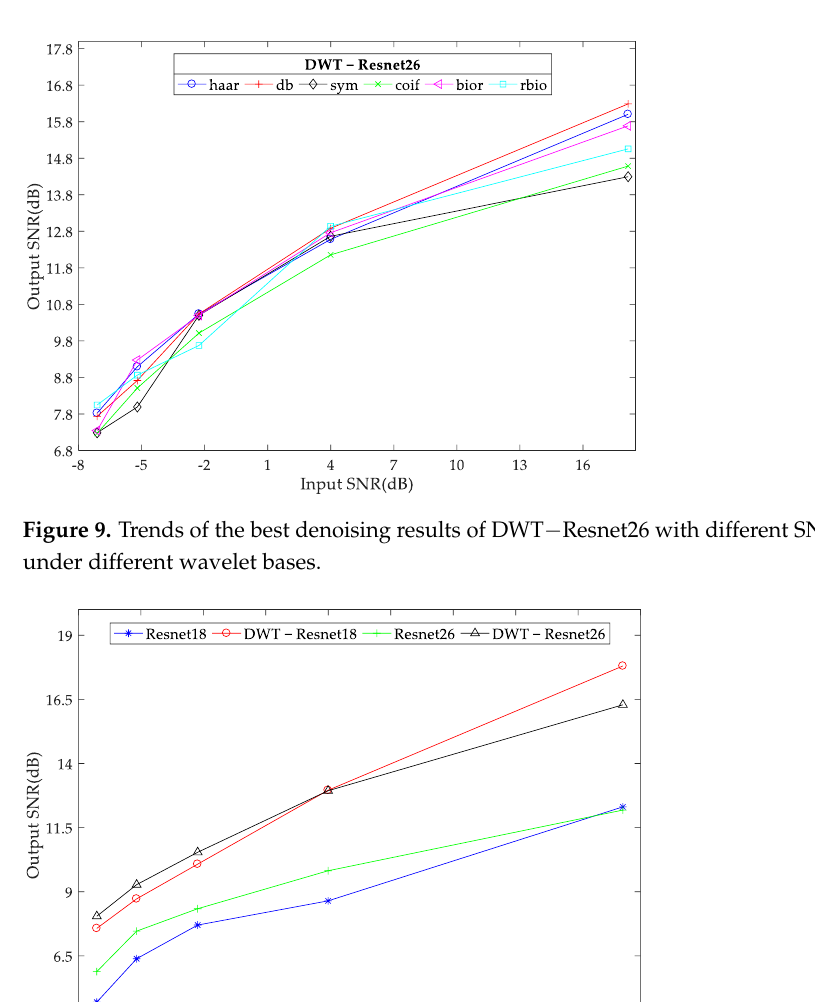
Figure 10. Comparison of denoising results using Resnet18, Resnet26, DWT − Resnet18, DWT − Resnet26 with different input SNRs.